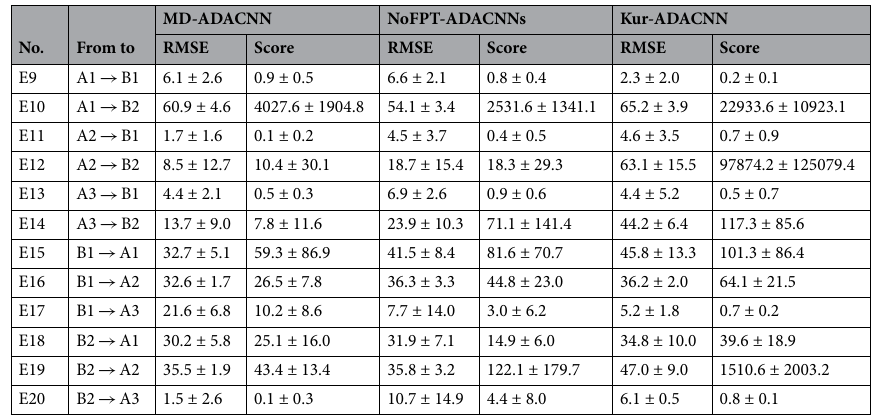
Table 6. RMSE/score ± standard deviation comparison under cross-platform on FEMTO and XJTU-SY.